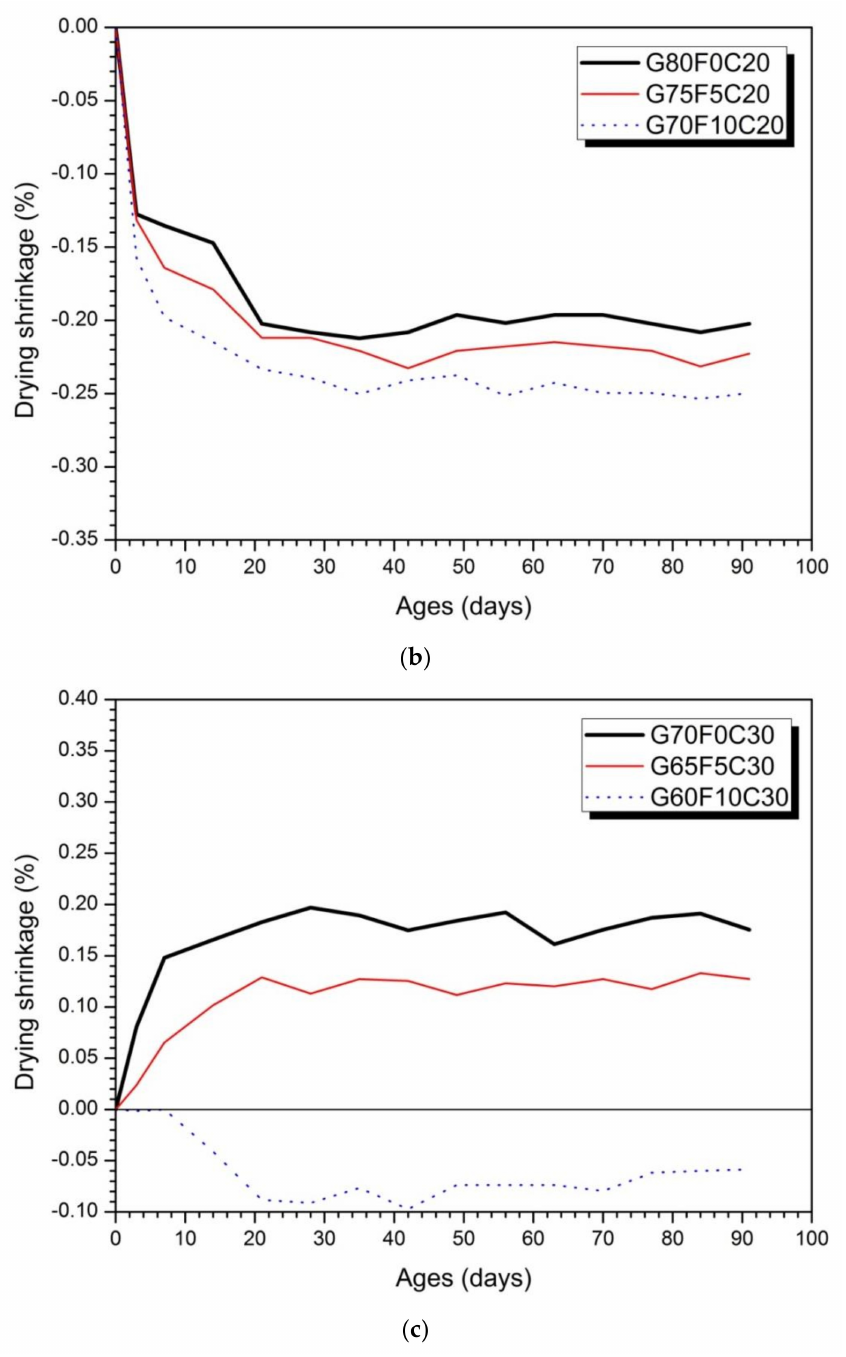
Figure 7. Drying shrinkage ratios, ( a ) 10% CSAe, ( b ) 20% CSAe, and ( c ) 30% CSAe. Chaunsali and Mondal [51] showed that, when CSA cement was substituted at 0%, 7%, 15%, and 30% in OPC, the specimen expanded as the CSA substitution rate increased. In particular, the 30% CSA sample showed cracking due to excessive expansion. In the current study, the 30% CSAe samples showed the highest expansion rate (Figure 7c). This high expansion produced fine cracks on the sample surface and also affected the sample interior, resulting in a decrease in the compressive strength and a change in the pore